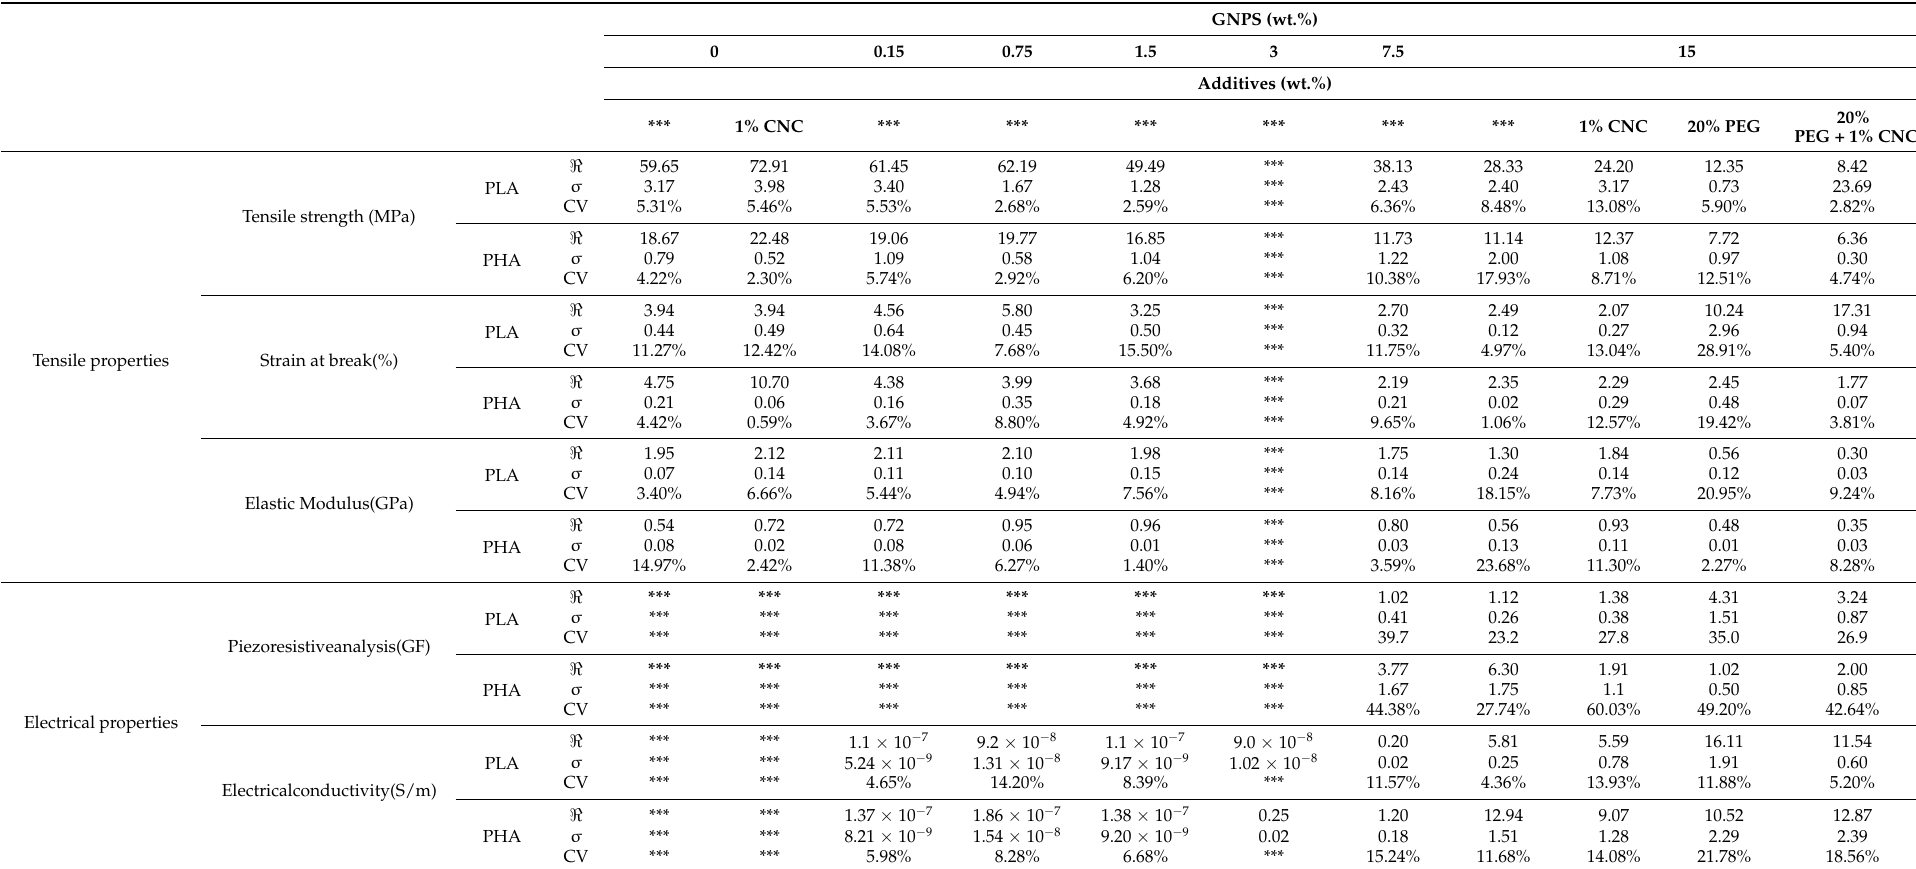
Table 3. Summary of the mechanical (tensile strength, strain at break and Elastic Modulus) and electrical properties (electrical conductivity and Gauge factor) of PHA and PLA composites with different additions (GNPs, CNC and